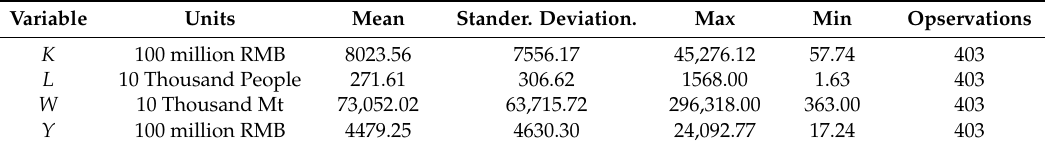
Table 1. Descriptive statistics for the relevant